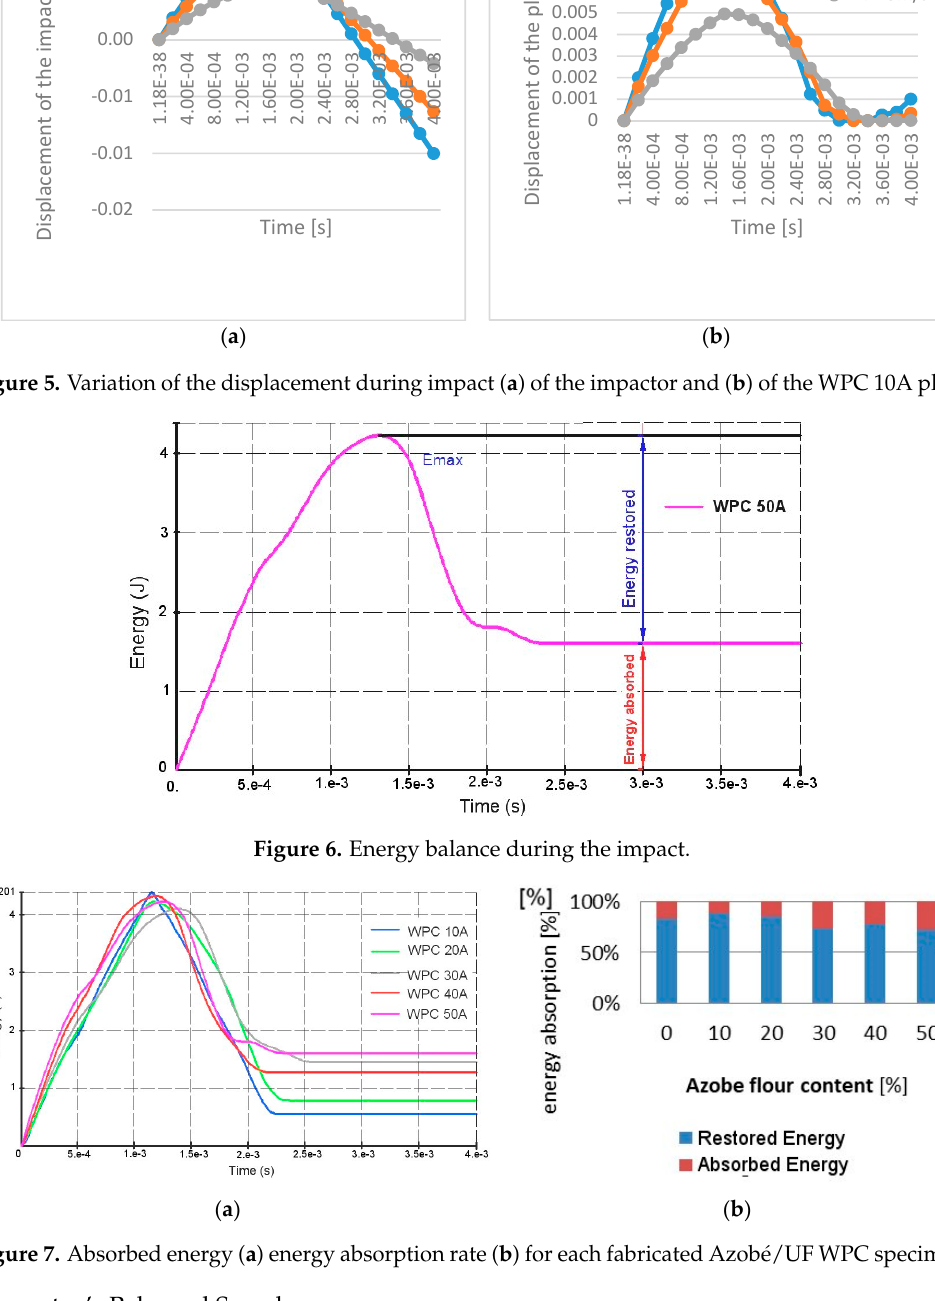
Figure 7. Absorbed energy ( a ) energy absorption rate ( b ) for each fabricated Azobé/UF WPC specimen.